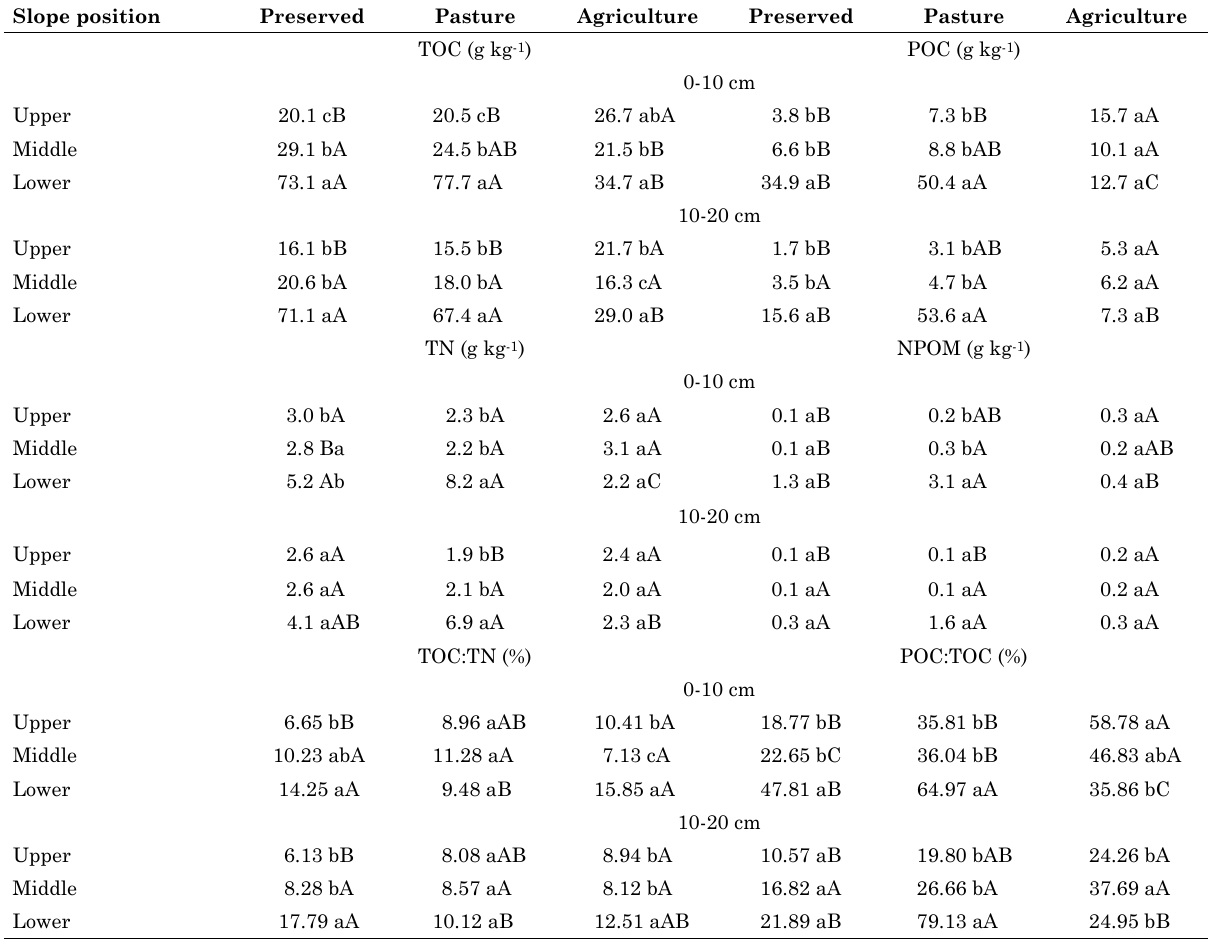
Table 2. Total organic carbon (TOC), total nitrogen (TN), soil C:N ratio (TOC:TN), particulate organic carbon (POC), nitrogen of particulate organic matter (NPOM) and particulate organic carbon by total organic carbon (POC:TOC) at different slope (relief) positions and conditions of use of the surrounding areas, in the 0-10 and 10-20 cm layers Slope